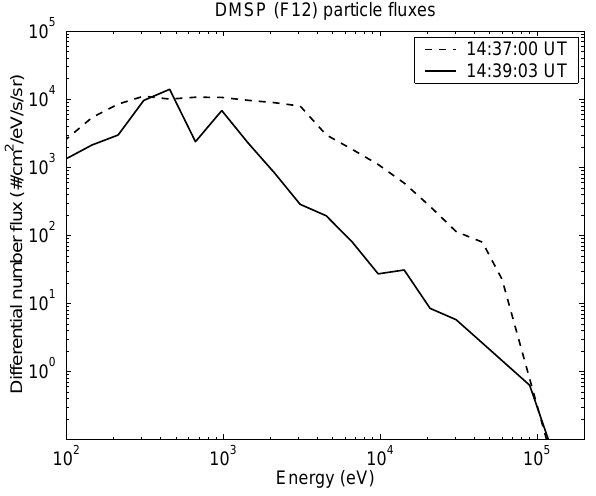
Fig. 10. DMSP F12 input particle flux at 14:37 UT and 14:39 UT with high energy